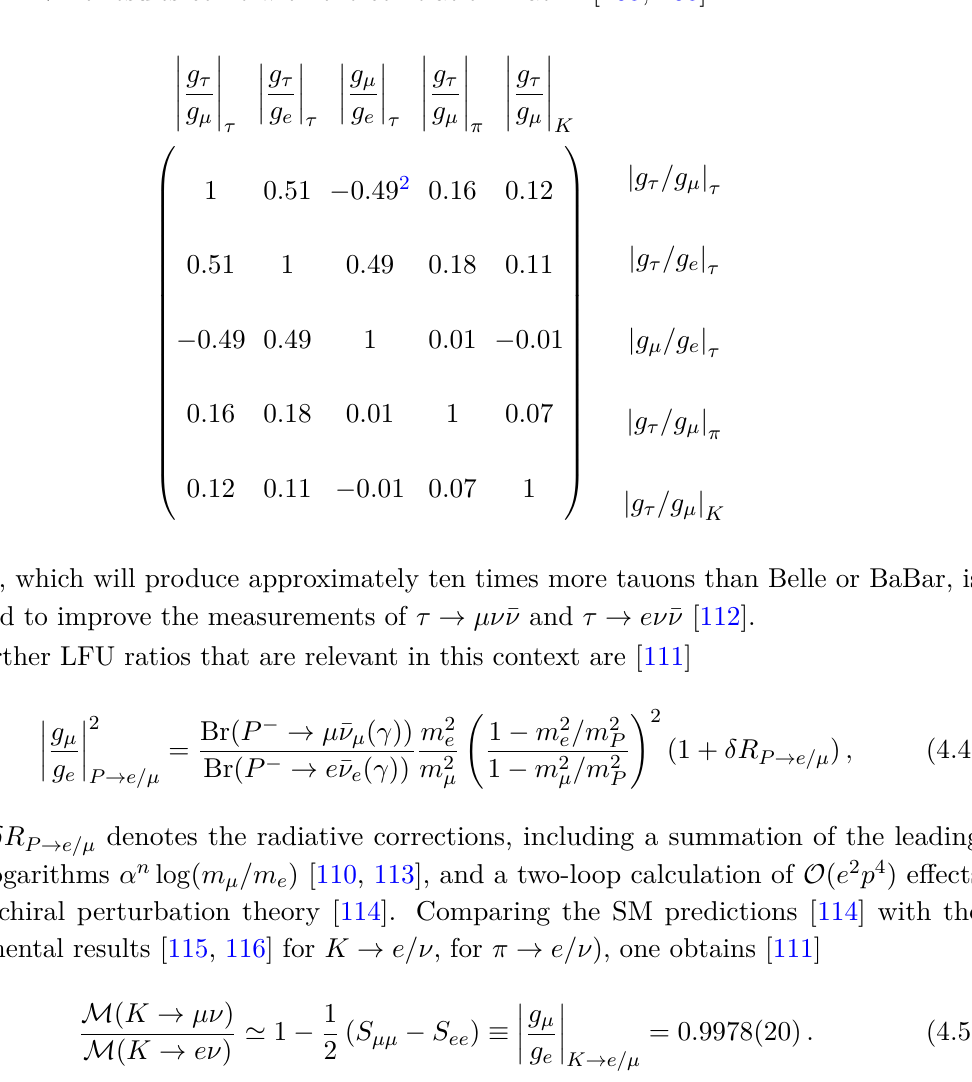
the new physics modification of eq. ii